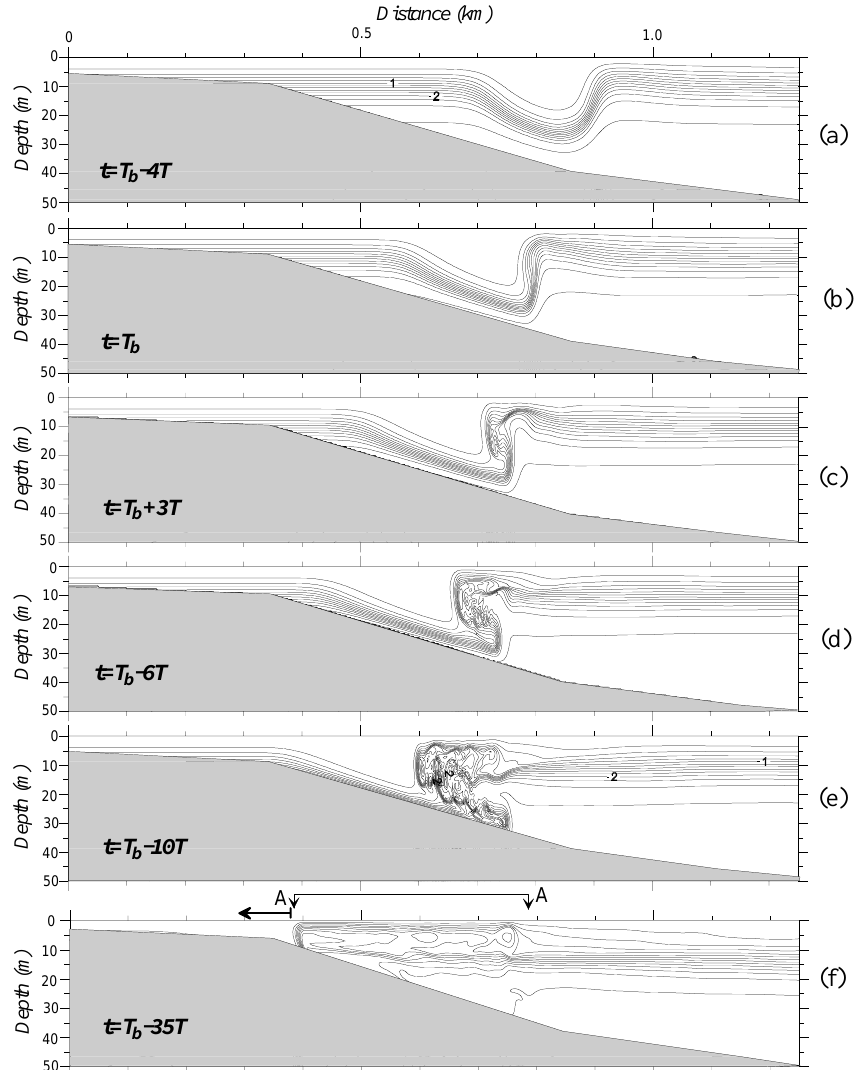
Fig. 8. Evolution of the density field during internal wave breaking near the lake boundary (along the cross section 3 in Fig. 1). The amplitude of the incoming wave is a m = 15m. The fluid stratification used is depicted by line 1 in Fig. 3. The density anomaly relative to the free surface is shown. The contour interval equals 0.2 kg · m − 3 , the time scale T equals 83s. Segment A - A represents a mixing zone with a newly formed fluid stratification after wave